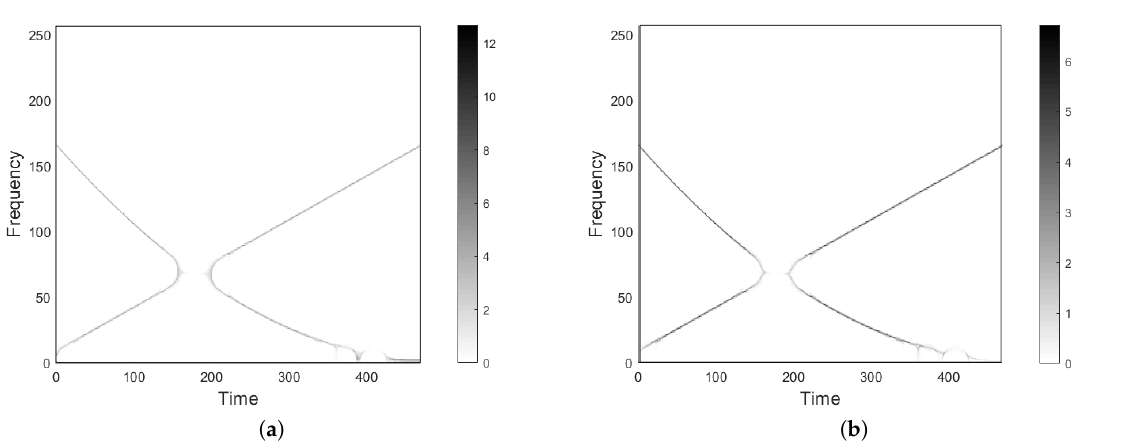
Figure 6. ( a ). Reassigned spectrogram of the two-component signal in Figure 2 using the algorithm in Equations (4) and (5); ( b ) Reassigned spectrogram of the same signal: only time-frequency points in Ω , as in Equation (34) have been considered—the not reassigned region reduces of nearly